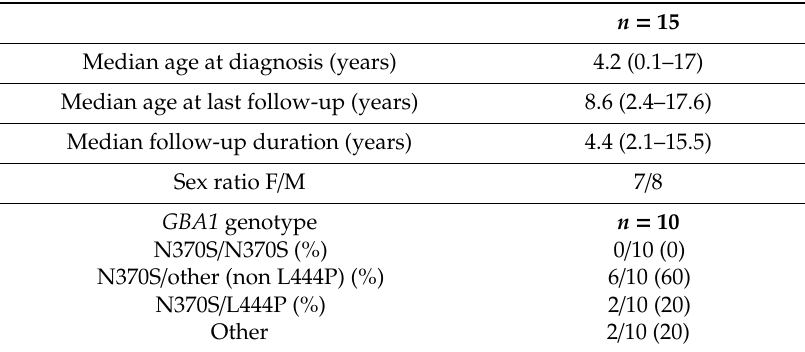
Table 4. Children’s